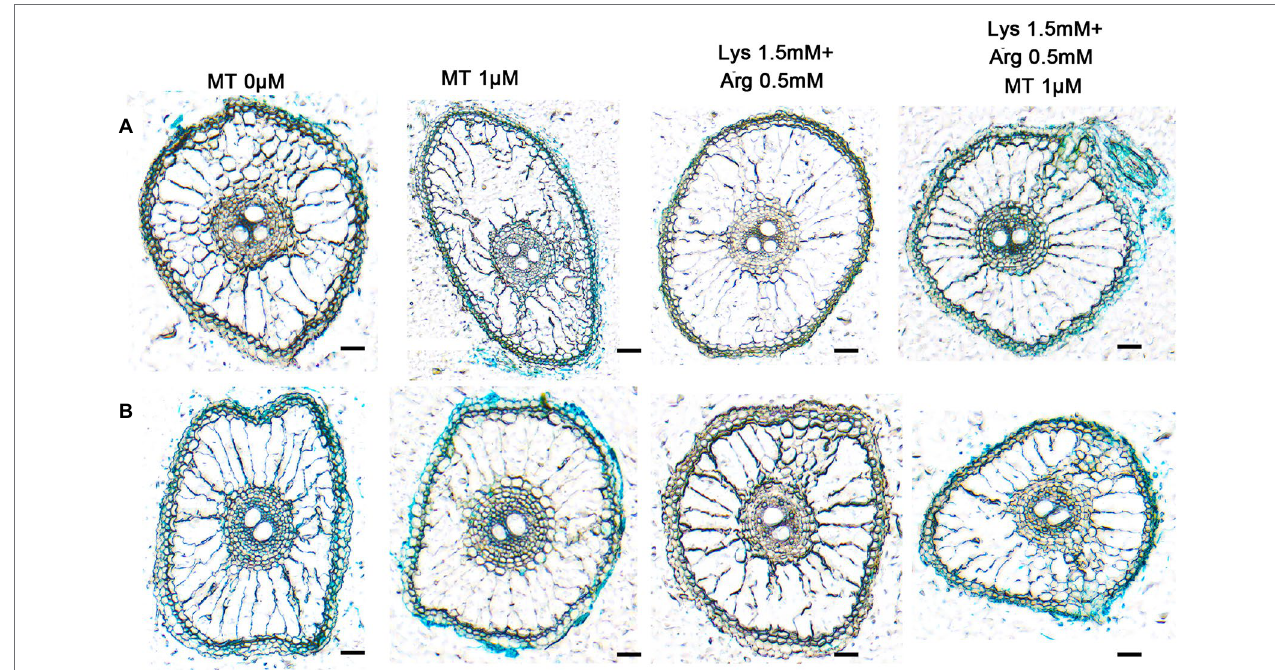
FIGURE 7 | Section analysis of OsAAP14 and OsGS2 promoter-GUS transgenic plants regulating by melatonin and amino acids. Promoter-GUS transgenic seedlings were grown under basic nutrient solutions supplemented with different concentrations of melatonin (0 μ m, 0.1 μ m, 1 μ m, 10 μ m), 1.5 mm Lys + 0.5 mm Arg, or 1.5 mm Lys + 0.5 mm Arg + 1 μ m melatonin. Paraffin sections of the stained roots of OsAAP14 (A) and OsGS2 (B) promoter-GUS transgenic plants. MT represents melatonin, Lys represents lysine, and Arg represents arginine. Scale bar = 40 μ